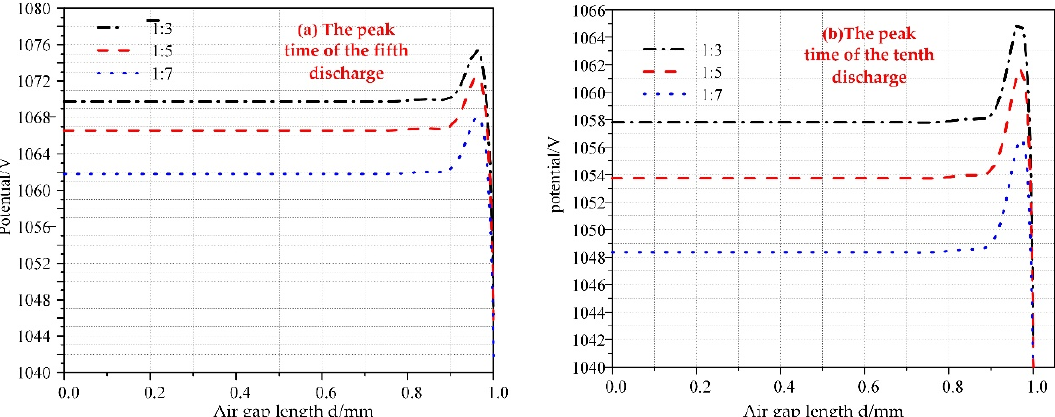
Figure 8. The potential at the fifth and the tenth discharge peak. ( a ) The peak time of the fifth discharge. ( b ) The peak time of the tenth discharge.